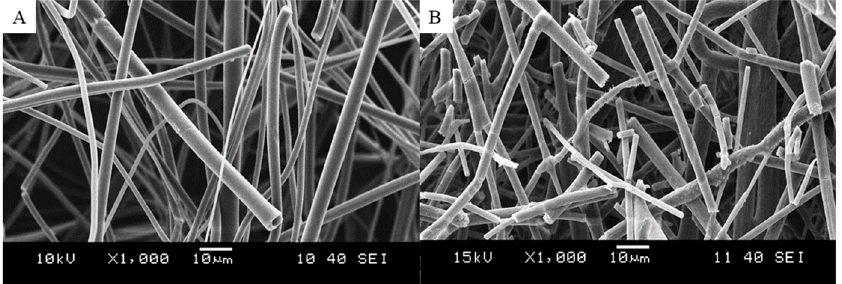
Figure 3. Scanning electron microscope images of β -galactosidase containing polyvinyl alcohol (PVA)-based fibers after electrospinning ( A ) and grinding ( B ) (at 1000-fold magnification).